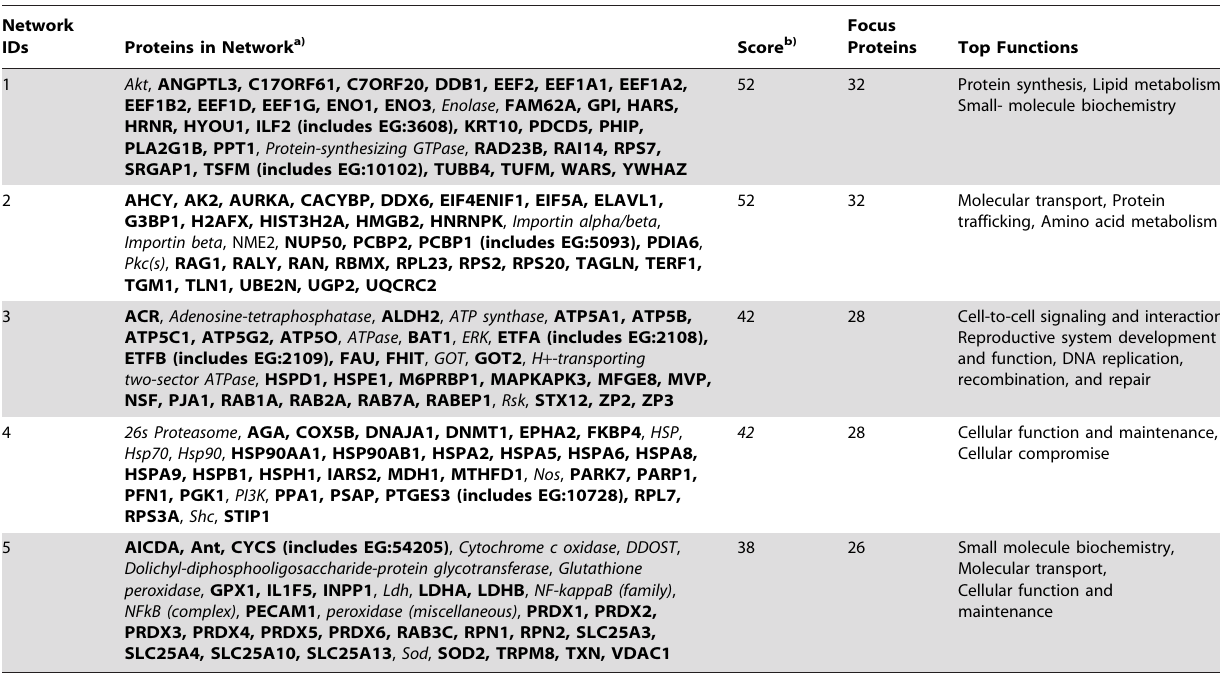
Table 1. The top five biological networks in bovine GV oocyte proteome.